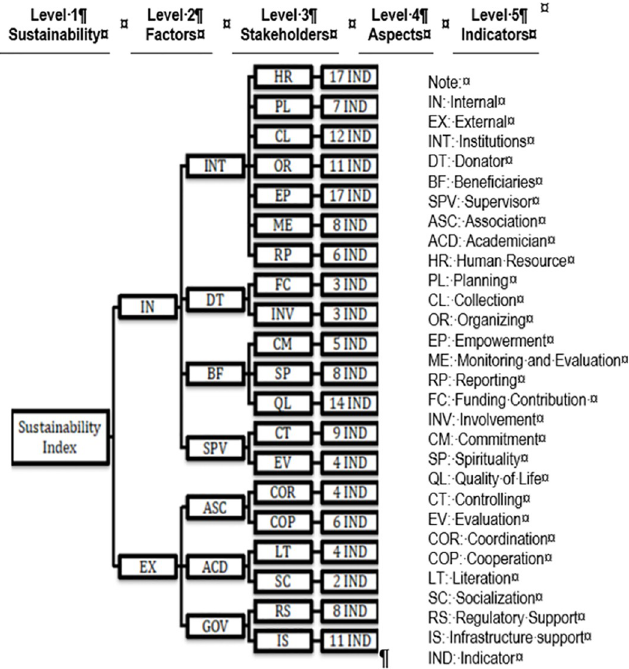
Fig 1. Research framework of sustainability index of Islamic Social Finance program. Source: Authors’